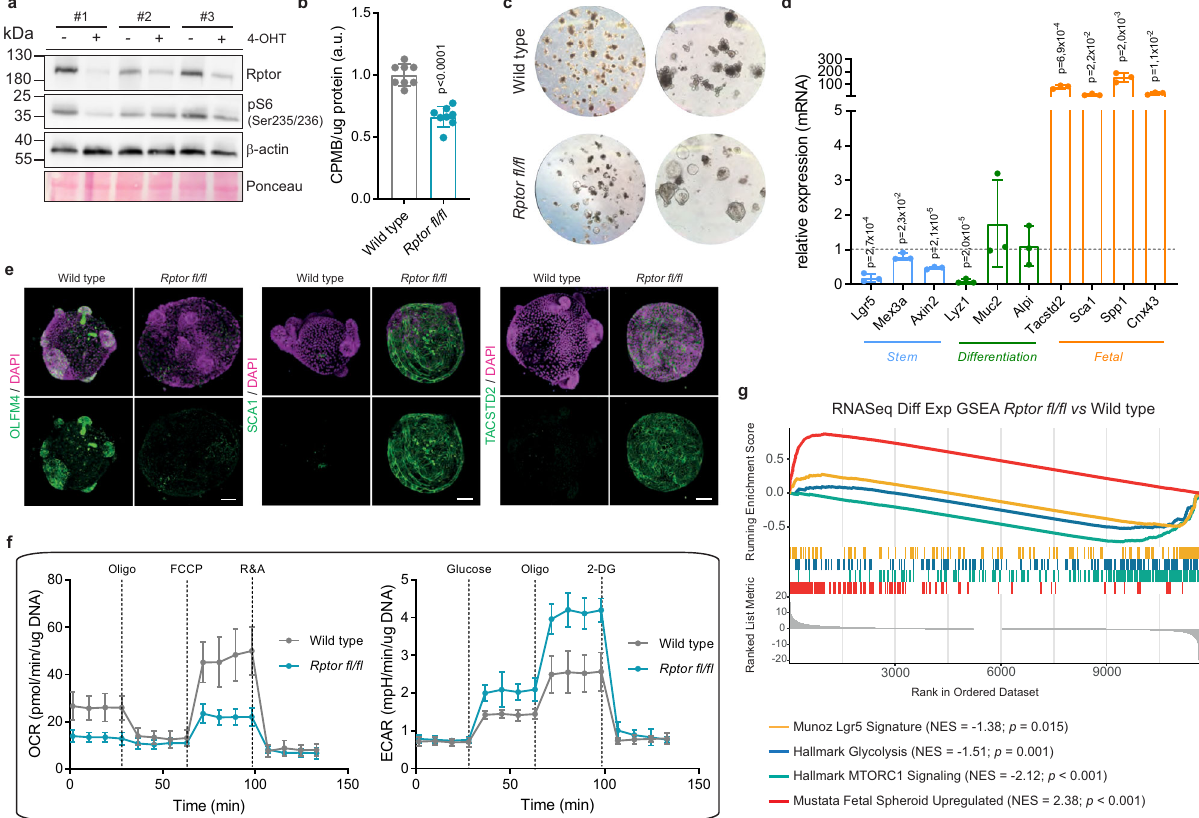
Fig.1|Inhibitionoftranslationdrivesstemcellidentitychanges.a Westernblot analysis con fi rming reduced Raptor and pS6 (Ser235/236) protein levels in cells from 3 different animals treated with 4-Hydroxytamoxifen. β -actin and Ponceau serve as loading control. b Incorporation of 35 S-methionine shows decreased pro- tein synthesis in Rptor fl / fl organoids compared to WT.Mean and standard deviation are shown ( n =4 biological replicates each accessed in technical duplicates). p values were determined using a two-tailed t -test. c Representative images showing morphologicaldifferencesinorganoidsupon Rptor loss,comparedtoWT.Pictures wereacquiredusing5x(leftpanel)and20x(rightpanel)magni fi cations. d RT-qPCR analysis ofindividualgenes related to stem ( Lgr5,Mex3a and Axin2 ), differentiation ( Lyz1, Muc2 and Alpi ),and fetal-like state ( Tacstd2, Sca1, Spp1 and Cnx43 ) of Rptor fl / fl organoids compared to WT, using Hprt as a reference. Mean and standard error of the mean are shown ( n =3 biological replicates each accessed in technical